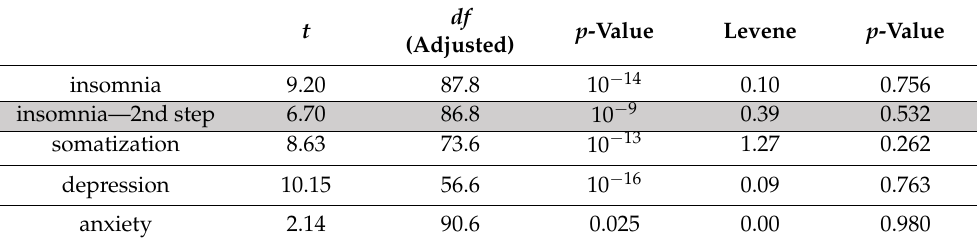
Table 3. For each symptom, the difference between those who screened negative vs. positive was Table 1. Levene’s F -statistic was used to test for significant differences in the variability of the comparison groups. Although no significant differences were found in variability, the most conservative adjusted df values were used to compute the p -values corresponding to the t-statistics. As in Tables 1 and 2 above, results are highlighted in gray for insomnia (2nd step). These were obtained when the regions which were selected for the first classification analysis were excluded. See the text for details.